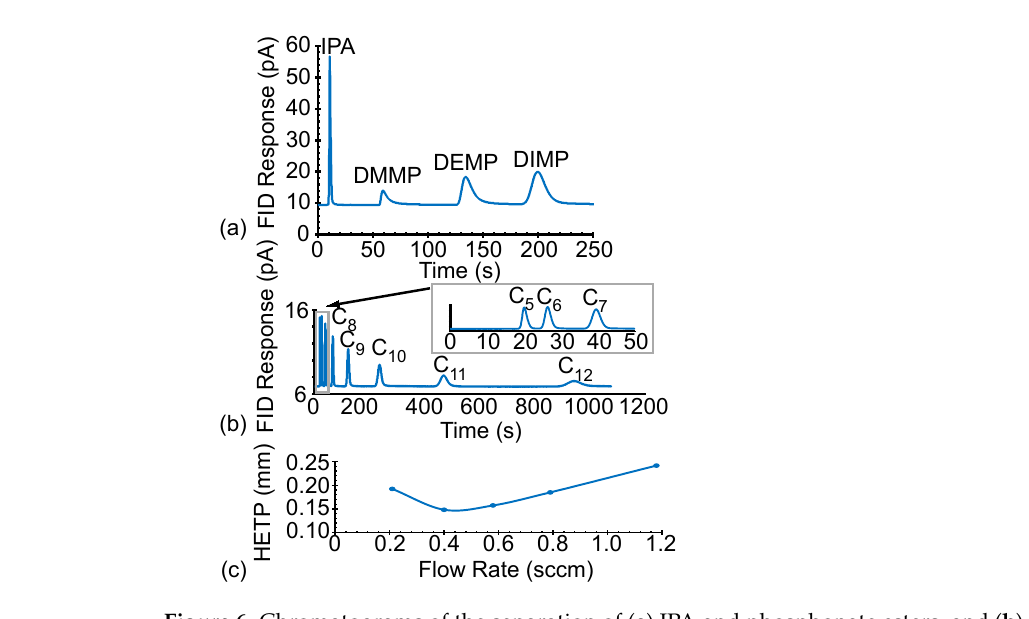
Figure 6. Chromatograms of the separation of ( a ) IPA and phosphonate esters, and ( b ) alkanes C 5 – C 12 in Column2. ( c ) The HETP of Column2 calculated using C 10 at 80 ◦ C at 0.2–1.2 sccm. Column3 showed similar HETP